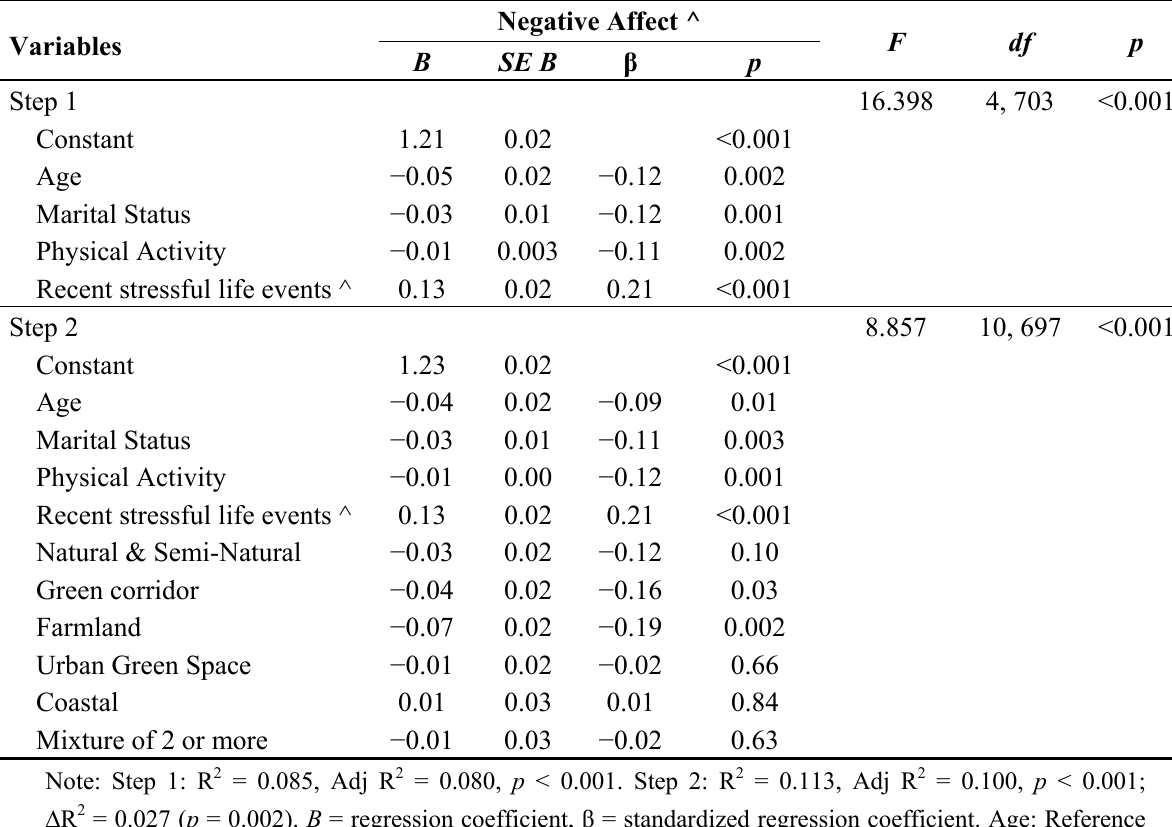
Table 9. Hierarchical regression analyses for variable predicting log-transformed negative affect for frequent group walkers attending at least once a week ( n =